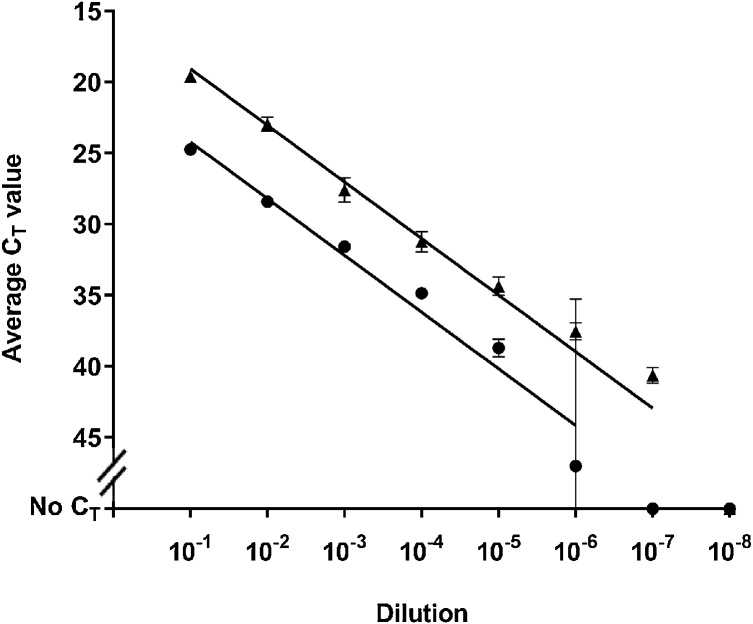
Detection of FMDV by rRT-PCR using Method B on ten-fold dilutions in Jersey whole milk of two milk samples: animal 867 (4.5 days post contact infection) and c27, a field sample from the UK 2007 outbreak (Table 2). CT values are the average of three replicates with standard deviation error bars. : 867 (4.5 dpc), : c27.